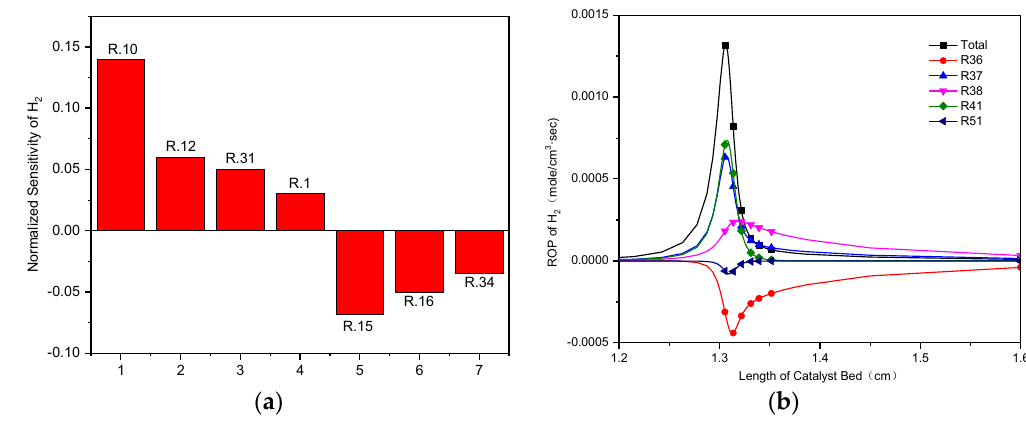
Figure 6. Sensitivity analysis and ROP analysis of the reaction steps on H 2 production: ( a ) Sensitivity analysis; ( b ) ROP analysis.